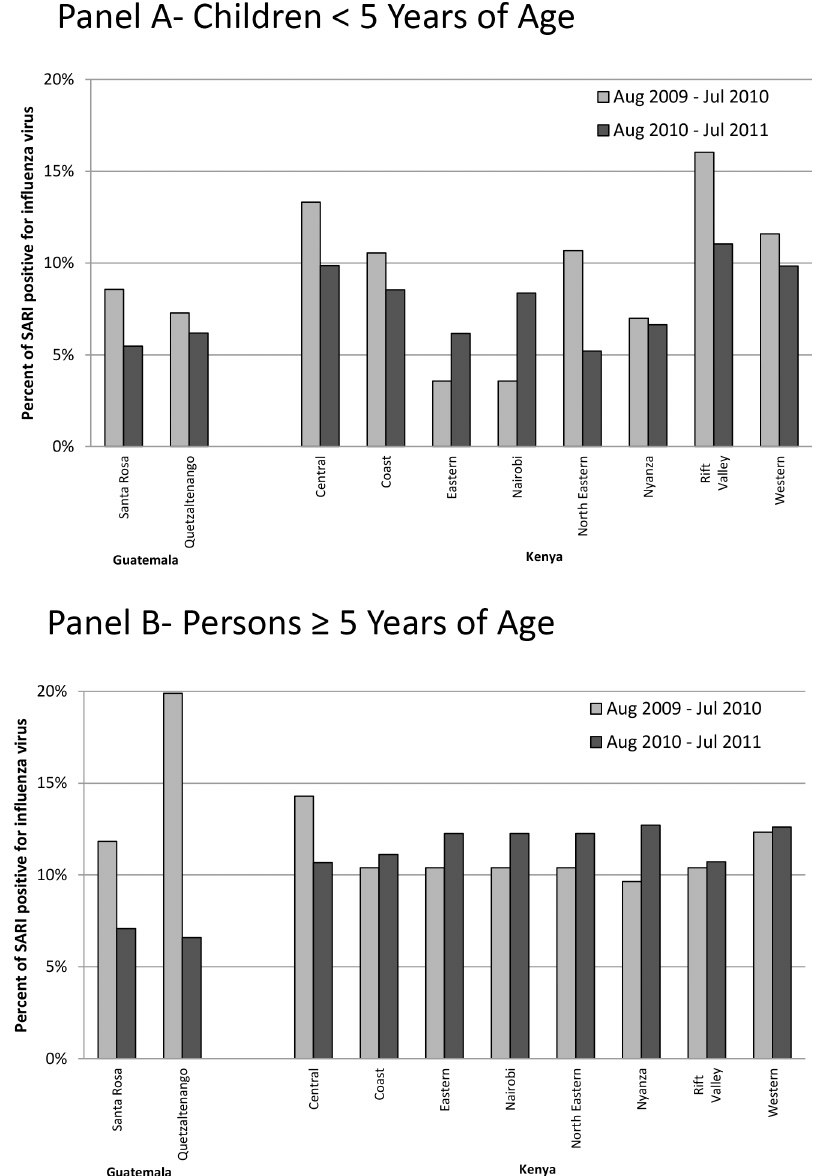
Figure 2. Percentage of severe acute respiratory infections (SARI) that tested positive for influenza by Guatemalan department and Kenyan province. August 2009-July 2011. Panel A-Children , 5 years old. Panel B- Persons $ 5 years